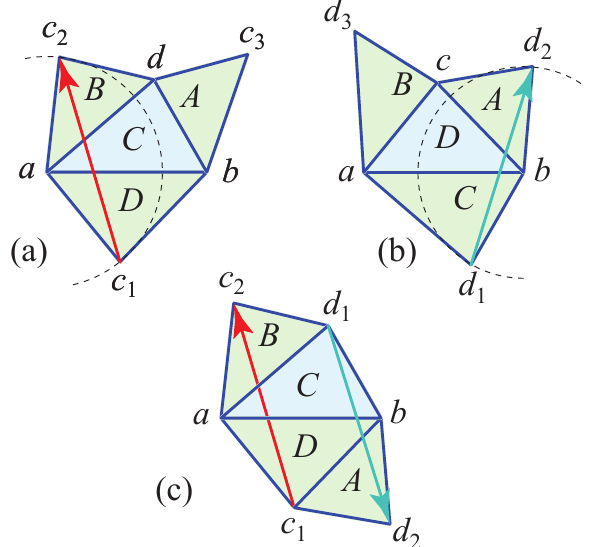
Figure 5. Case 2.2.2: c is closest to a and d is closest to b . ( a ) Q c red. ( b ) Q d green. Curvatures at a , b , c , d are 226 ◦ ,205 ◦ ,138 ◦ ,151 ◦ . ( c ) The two segments c 1 c 2 and d 1 d 2 are slightly non-parallel.